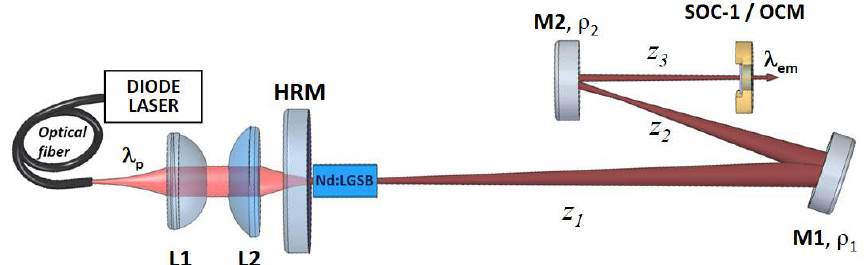
Figure 3. The laser resonator designed for ML experiments; z 1 , z 2 , z 3 , the resonator arm lengths; M1, (cid:37) (cid:37) 1 , 2 , radius of M2, folding mirrors; ρ 1 , ρ 2 , radius of curvatures. M2, folding mirrors;